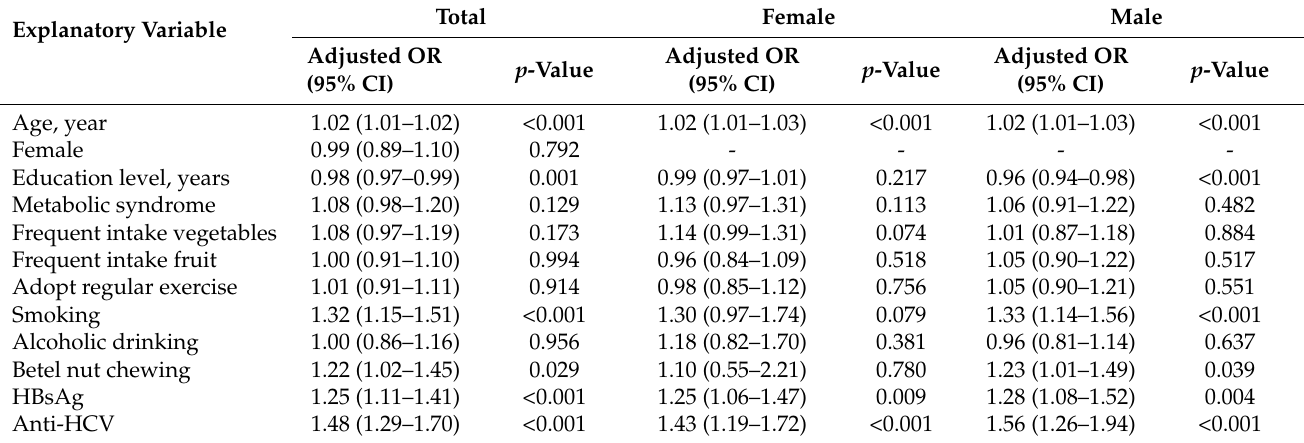
Table 5. Association between the demographics/characteristics and the risk of higher level of